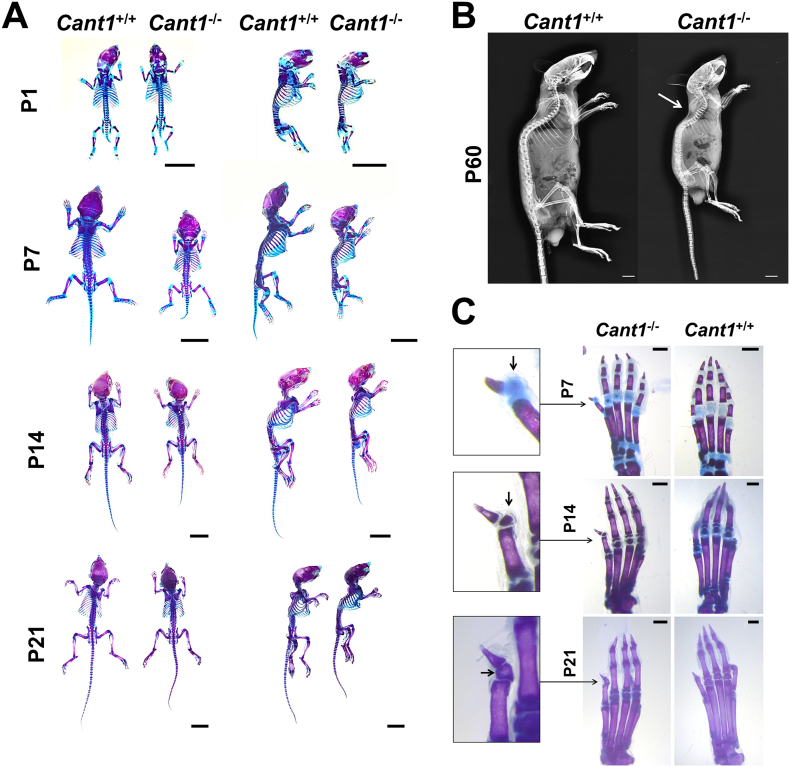
Skeletal phenotype of Cant1 knock-out mice is reminiscent of the DBQD1 patients' phenotype. (A) Alcian blue and alizarin red staining of full skeletons from birth to P21 showed that Cant1−/− mice were smaller compared with age matched wild type (Cant1+/+) controls. Scale bars = 1 cm. (B) X-ray analysis of two month old (P60) Cant1−/− and Cant1+/+ mice showed reduced growth of Cant1−/− compared with wild type animals. Moreover, a moderate thoracic kyphosis (arrow) was observed in Cant1−/− mice. Scale bars = 1 cm. (C) Alcian blue and alizarin red staining of the hind limb extremities at different ages revealed the presence of a delta phalanx (arrow) in Cant1−/− mice at all ages. Scale bars = 1 mm.